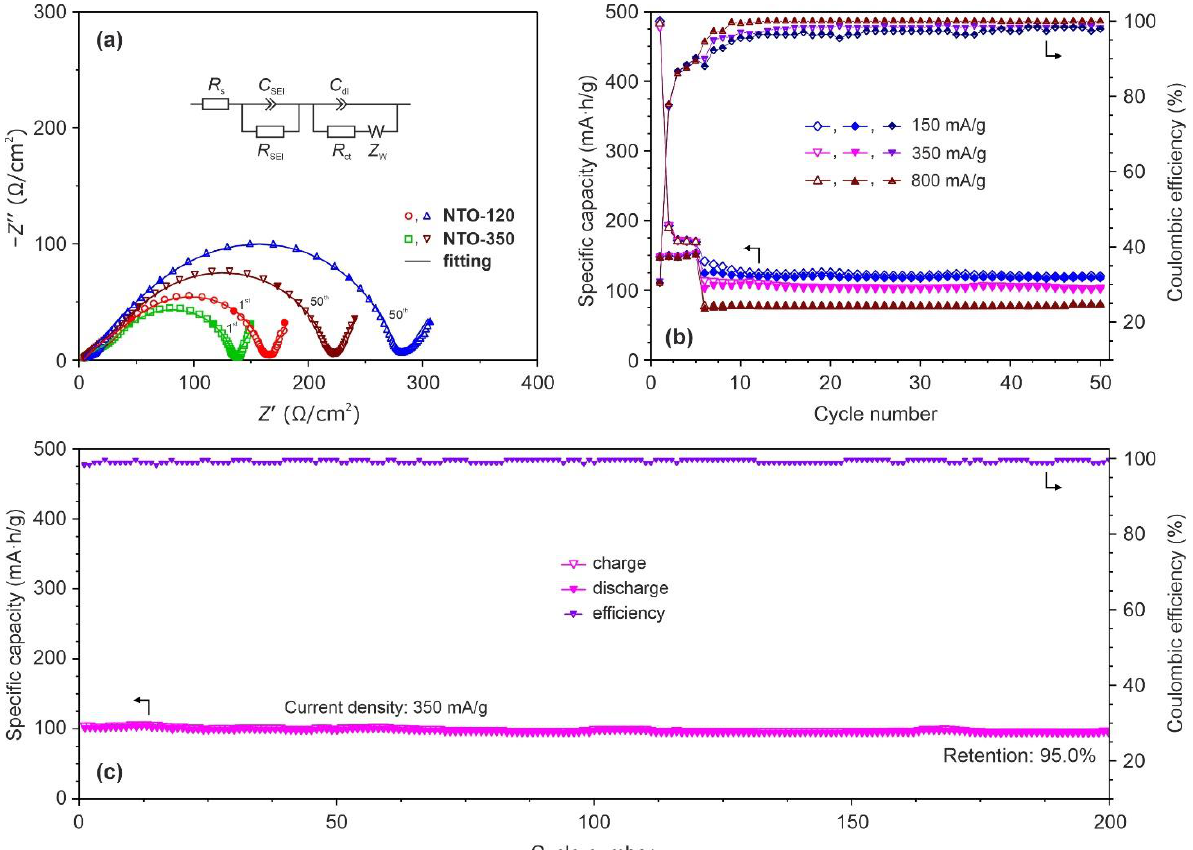
Figure 8. Impedance spectra registered at a fully sodiated state (at a potential of 0.01 V) during 1st and 50th cycles for analyzed materials (filled symbols denote the frequencies of 10 3 , 10 2 , and 10 −2 Hz) with an electrical equivalent circuit (inset) applied for fitting ( a ), rate capability data (charge and discharge capacities are marked by filled and open symbols, Coulombic efficiencies are designated by semi-open symbols) after five initial formation cycles at 50 mA/g ( b ), and prolonged cycling performance at 350 mA/g ( c ) for the NTO-350 electrode.